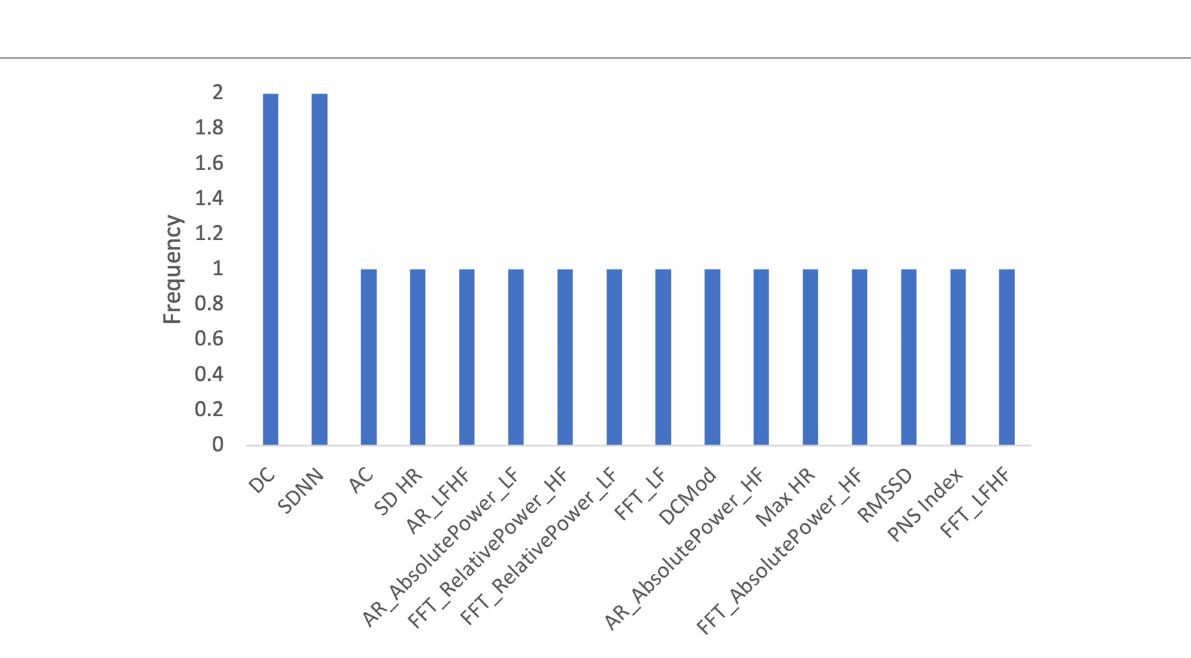
FIGURE 18 Frequency of features in profession-related